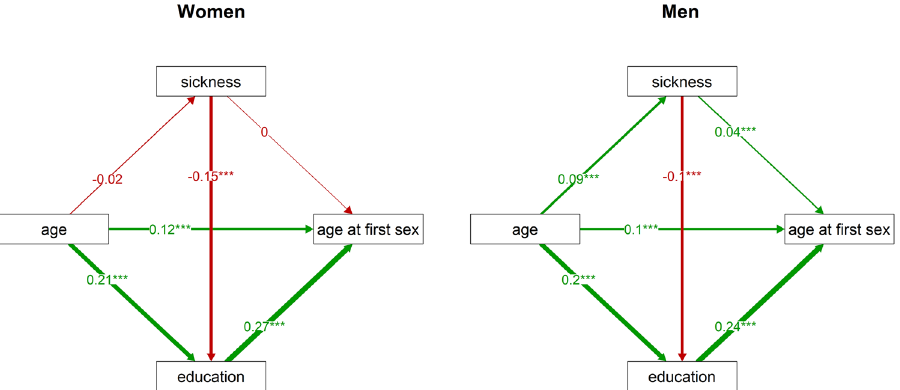
Figure 2. Direct and indirect effects of the sickness index on age at first sexual intercourse in women and men. This figure visualises the results of path analyses: it demonstrates relations between age at first sexual intercourse, the sickness index, education, and age, separately for women (left) and men (right). The numbers at arrows show standardised parameter estimates. Associations with p values under 0.001 are marked by ‘***’.